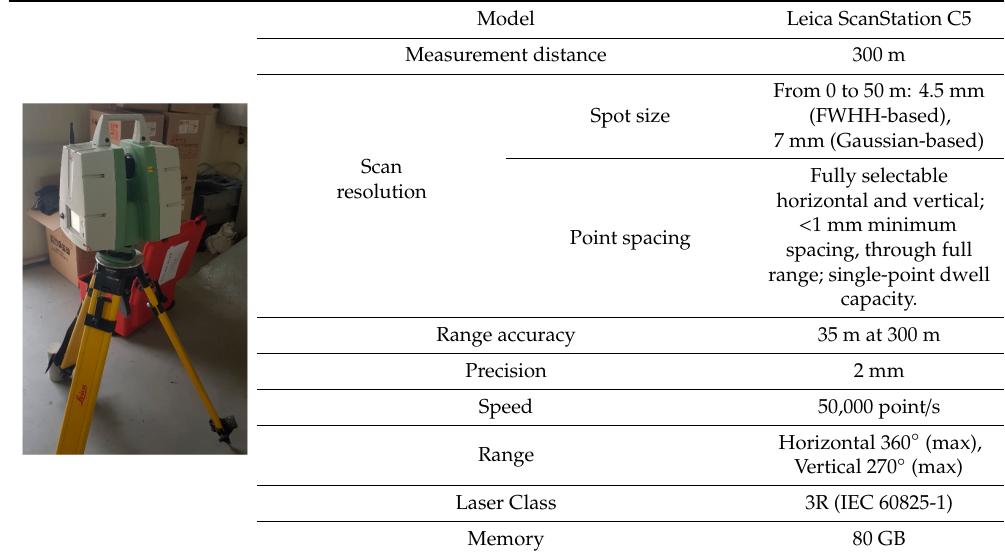
Table 1. Specifications of the terrestrial laser scanner.